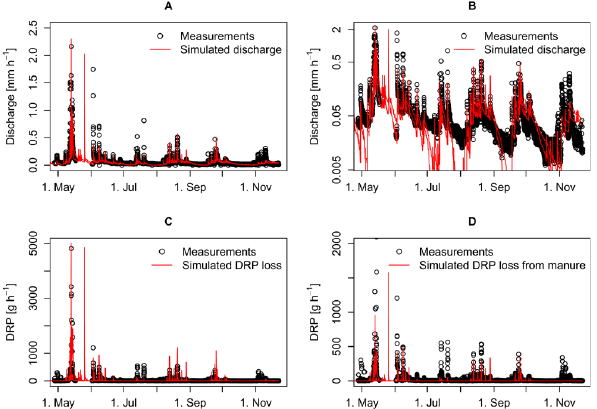
Fig. 2. Simulations (lines, 10% and 90% quantiles) using RRP Ver- sion 2 versus measured (points) discharge and DRP loss from the Lippenrütibach catchment in 1999. The y axes in figures on the right are in logarithmic scale ( B ) or focus on a certain part of the value range ( D ). (C) shows the total range of the DRP loads measured and simulated on a non-log scale.